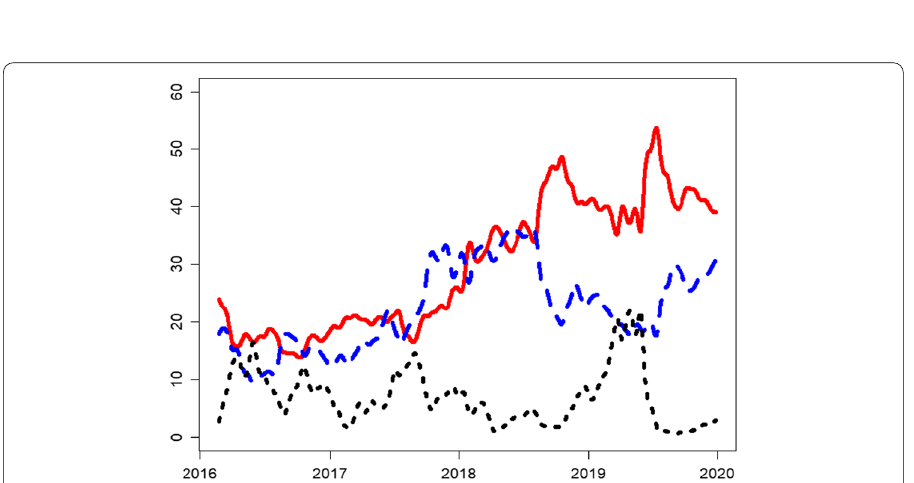
Fig. 10 Rolling-window based total return spillover index based on the BK approach. Note : 200 days rolling window, lag order 12 based on AIC. Short-run (0–5 days) is in red color; medium-run (6–56 days) is in blue color; long-run (more than 56 days) in black